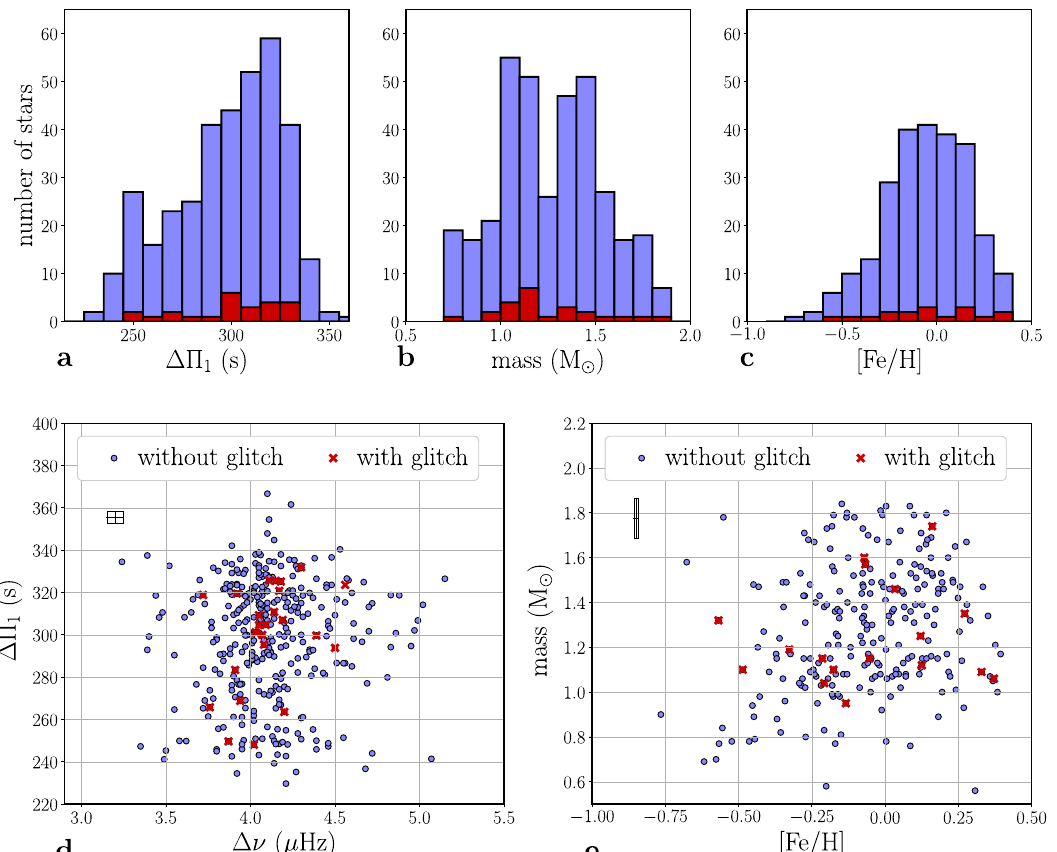
Fig. 3 | Properties of stars with and without detected glitches. Histograms representing the numberof stars asa function ofthe periodspacing ΔΠ 1 ( a ),mass ( b ) and metallicity ( c ) present in the full sample (in blue) and the stars for which a discontinuitywasfound(inred).Periodspacingasafunctionofthelargefrequency separation( d )and stellarmassasafunctionofmetallicity( e )forthetotalanalyzed sample (blue circles) and the stars for which a discontinuity was found (red